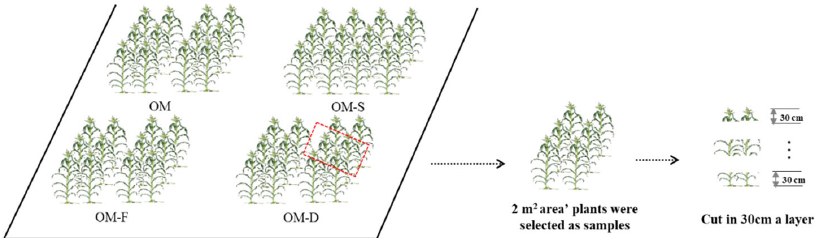
Figure 9. The sketch map of the samples collection method of canopy vertical structure. 2 m 2 area’ plants were selected as samples and cut in layers from the ground to plant top in 30 cm a layer. The red box was used to show that the 2 m 2 area’ plants was selected as samples from different treatments in the left sub ‐ graph.